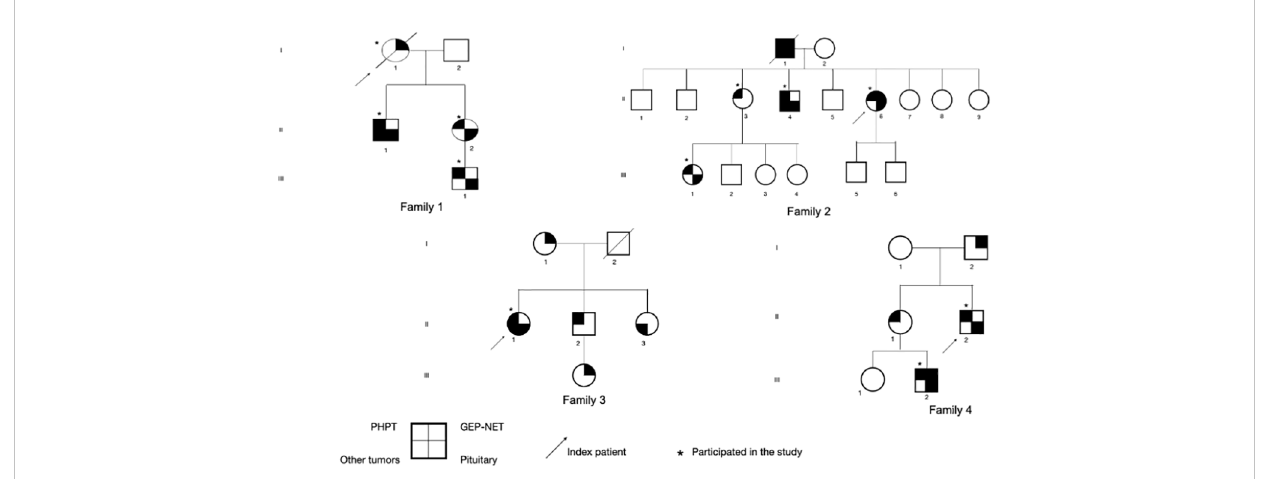
FIGURE 1 Representation of four pedigrees with clinical/familial MEN1. PHPT, primary hyperparathyroidism; GEP-NET, neuroendocrine tumors of gastroenteropancreatic tract; MEN1, multiple endocrine neoplasia type